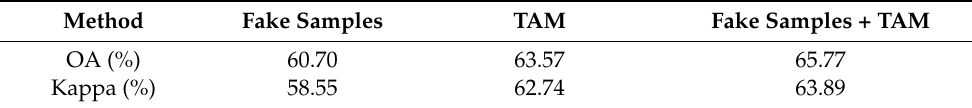
Figure 17. Attention maps derived from the VGG16 network by different methods. ( a ) Original remote sensing images. ( b ) Visualization results of the original images. ( c ) Visualization results of the fake samples by rotation. ( d ) Visualization results of the fake samples by flip. ( e ) Visualization results of the fake samples by the improved SinGAN. Table 7. Classification results of different augmentation